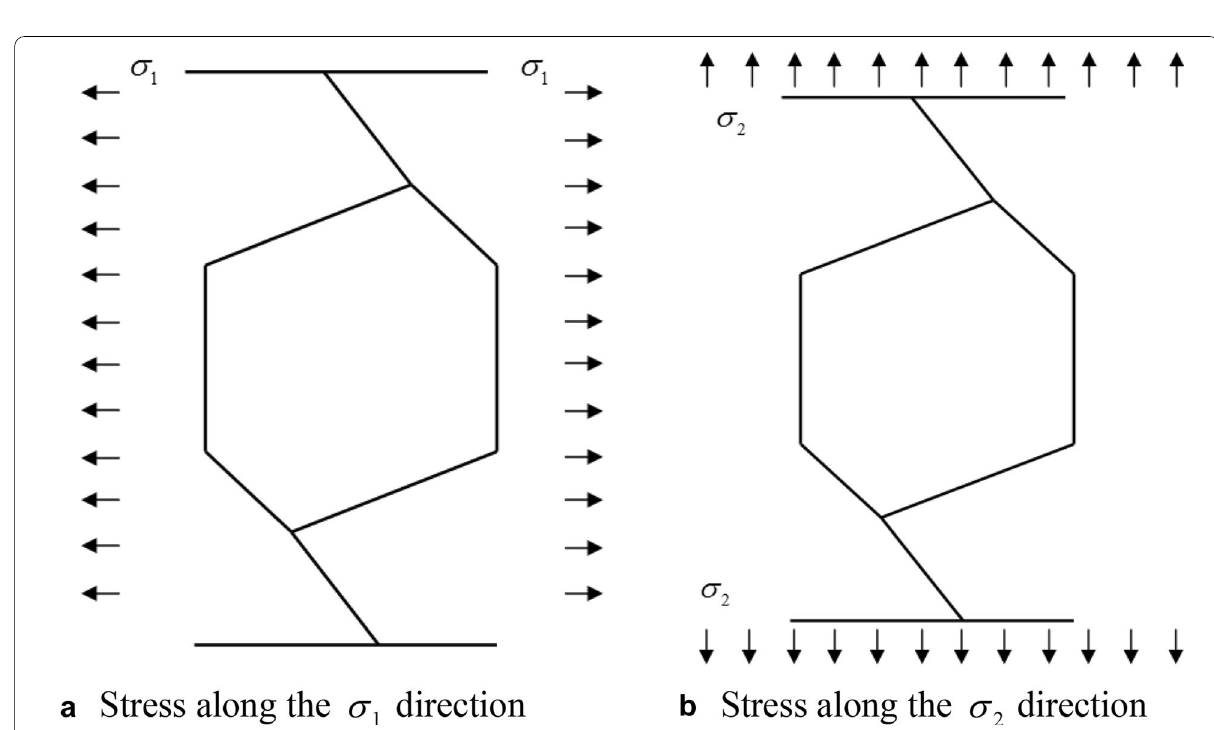
Figure 3 Applied tensile stresses in the ( a ) σ 1 and ( b ) σ 2